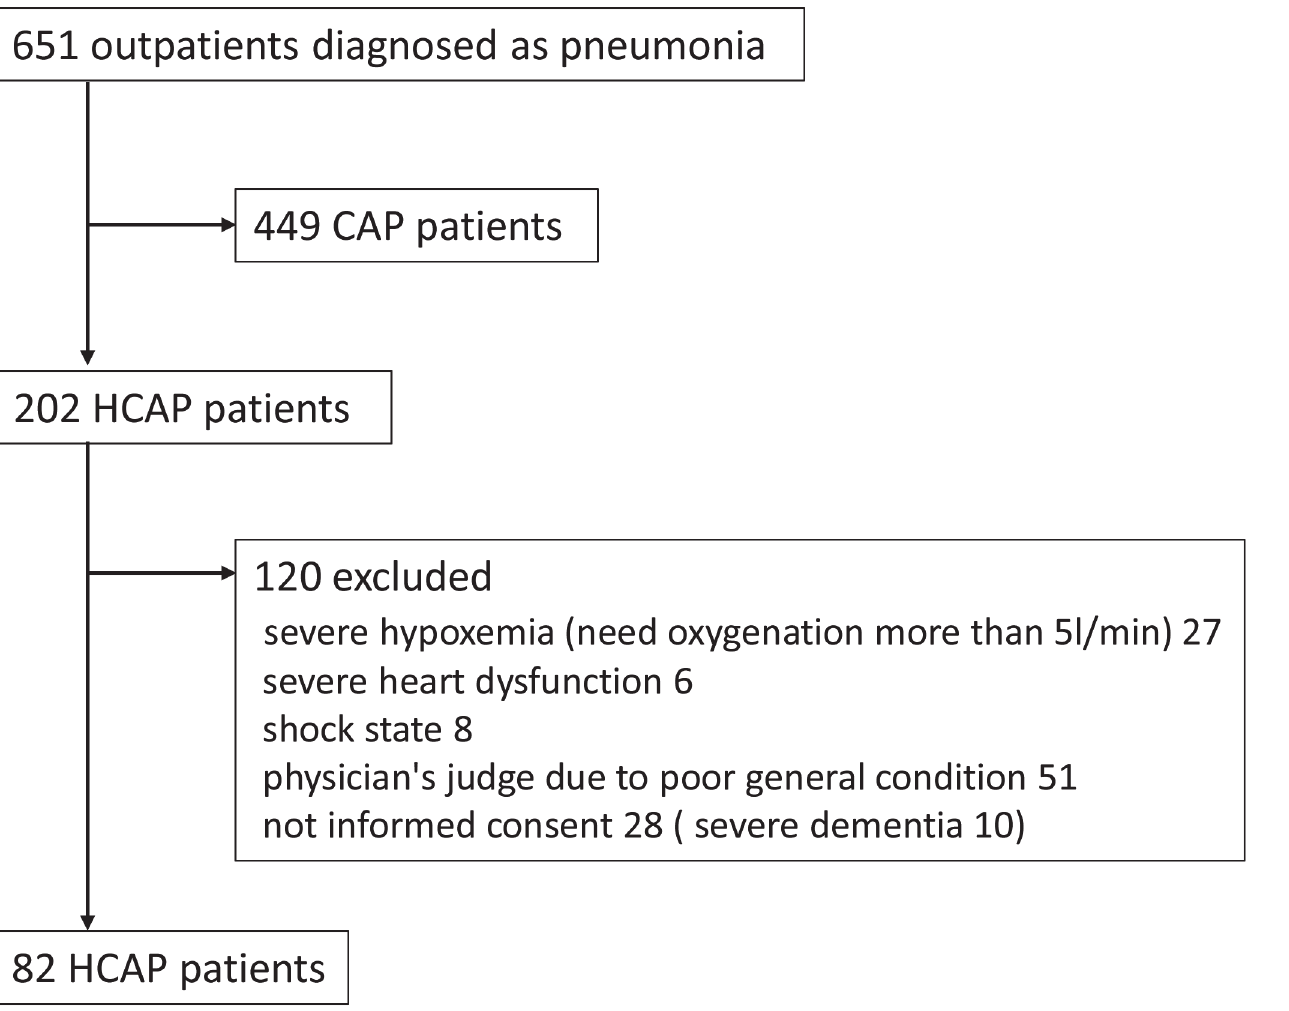
Fig 1. Patient inclusion and exclusion flow